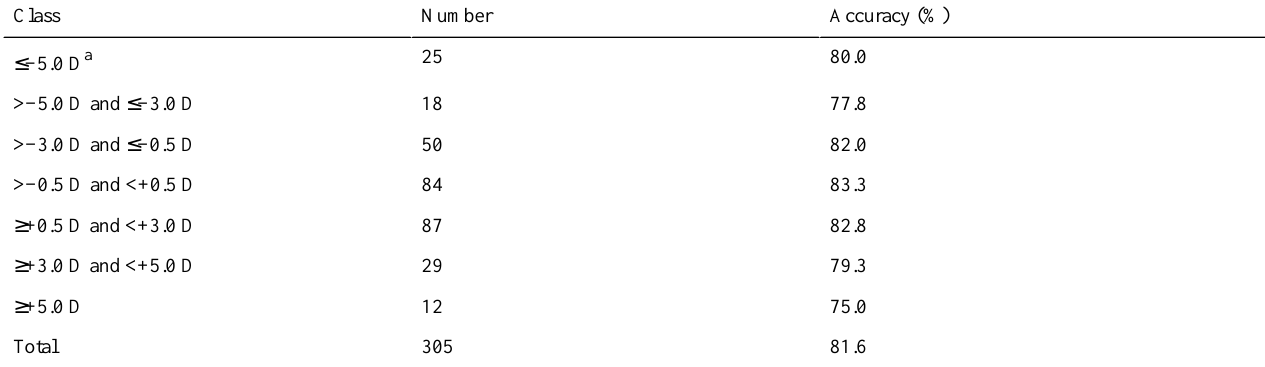
Table 4. Performance of our deep convolutional neural network with the overall test